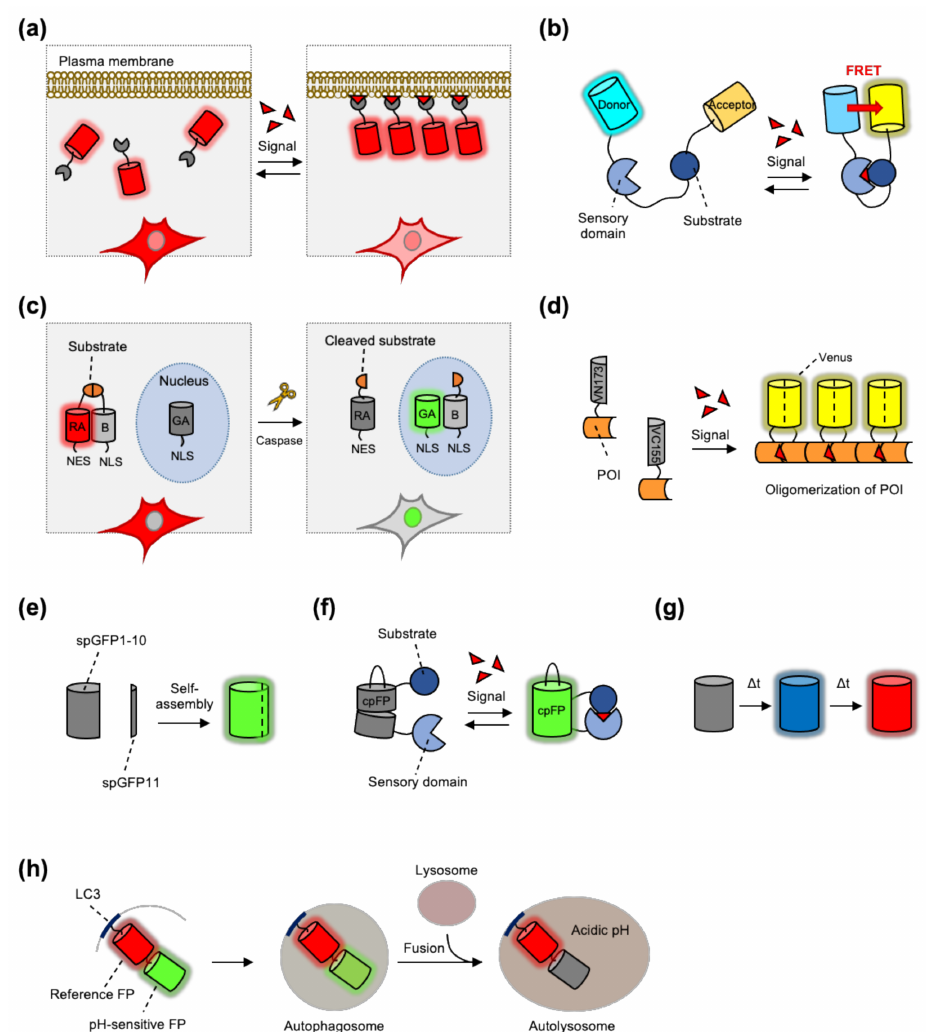
Figure 1. Sensing strategies of genetically encoded biosensors based on fluorescent proteins